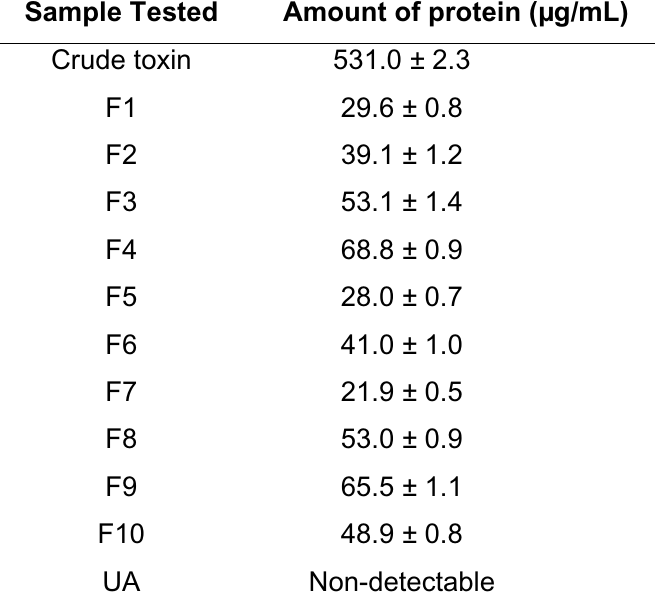
Table 1. Protein content of crude toxin, and its partially purified fractions, from the starfish Stellaster equestris (all values are means of triplicate